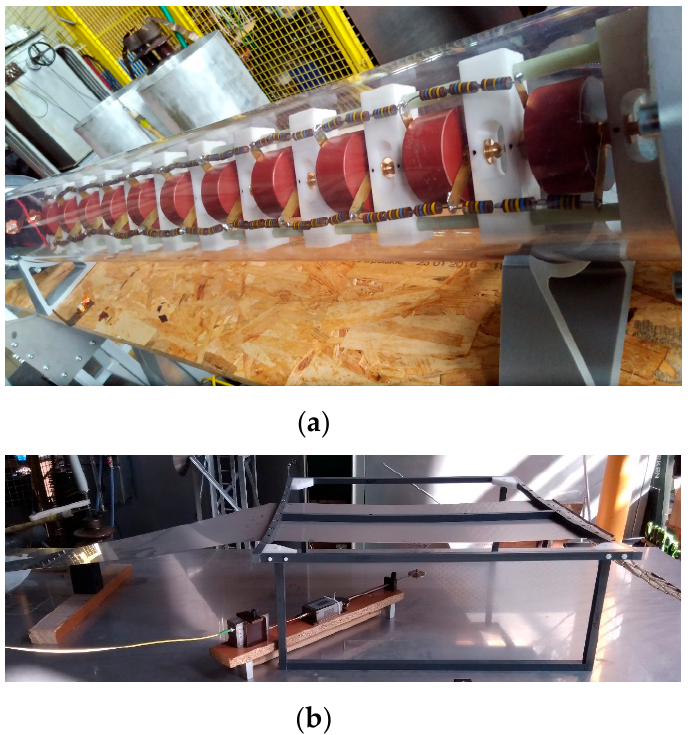
Figure 2. Photo of the Marx generator in hermetic sealing ( a ) and stripline with the field sensor ( b